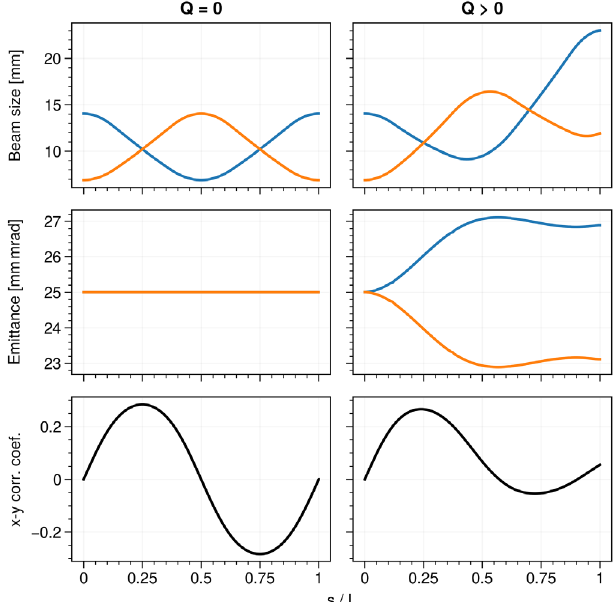
FIG. 3. Beam evolution within a FODO lattice without (left) and with (right) space charge. The lattice has period length L . Blue (orange) corresponds to the x ( y ) direction.